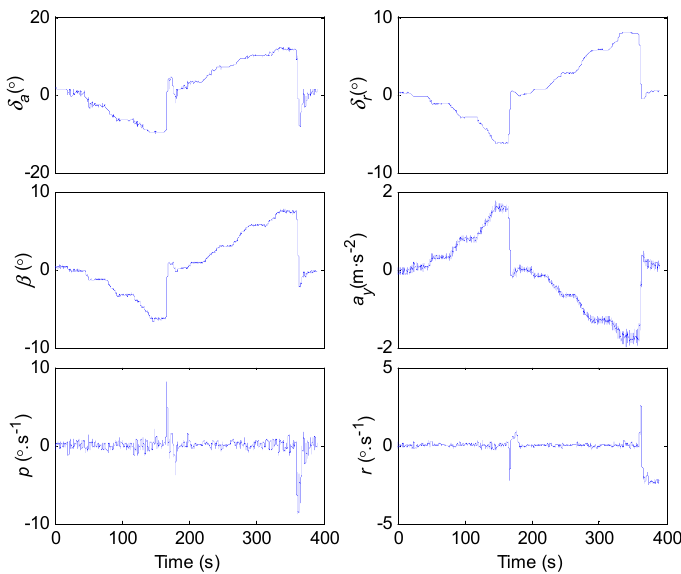
Figure 11. The flight test data of control and motion variables in steady heading sideslip.